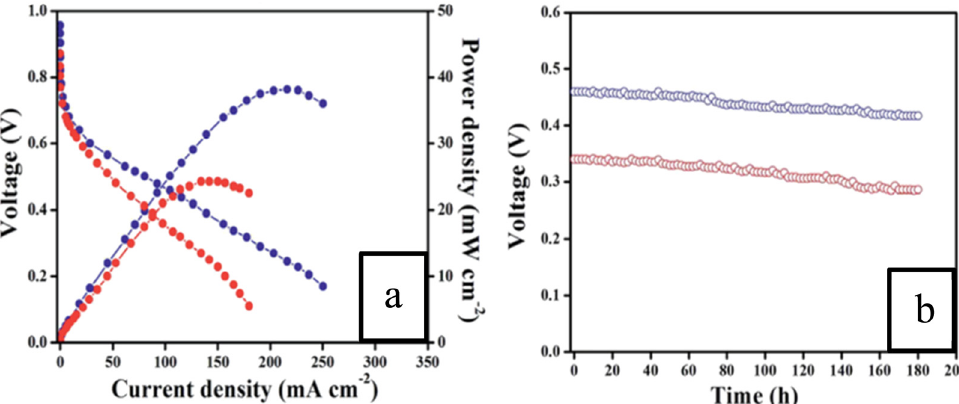
Figure 9: DUFC performance of NiCo 2 O 4 /CC using urea ( blue line ) and human urine ( red line ) at 80°C ( a ) , and durability test of NiCo 2 O 4 /CC in urea ( blue line ) and human urine ( red line ) for 180 h at 80°C ( b ) , republished with permission of Royal Society of Chemistry, from ref. [ 94 ] ; permission conveyed through Copyright Clearance Center,